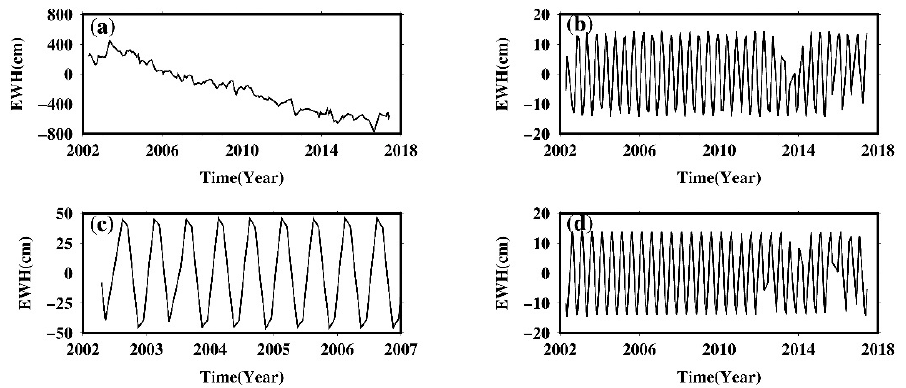
Figure 12. ( a ) Time series of point A at Figure 10 from CSR mascon data; ( b ) the fitted 171.2-day P 1